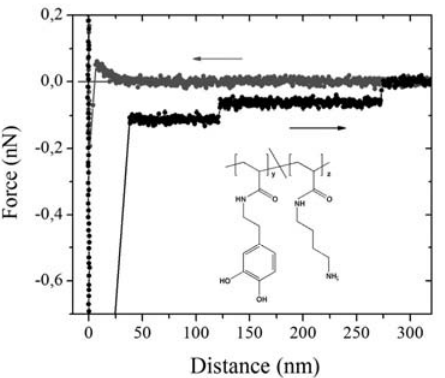
Fig. 8 Representative force-versus-distance curve obtained with p(DMA-co-BMA) (20% DMA, 80% BMA). The sample had been immersed in p(DMA-co-BMA) before the experiment. The force curve was recorded with titanium- coated tips and titanium-coated samples in aqueous 1 mM KNO pH 6.8 solution. Red is the approaching part, 3 black the retracting part of the force curve. For details see ref. 64) .